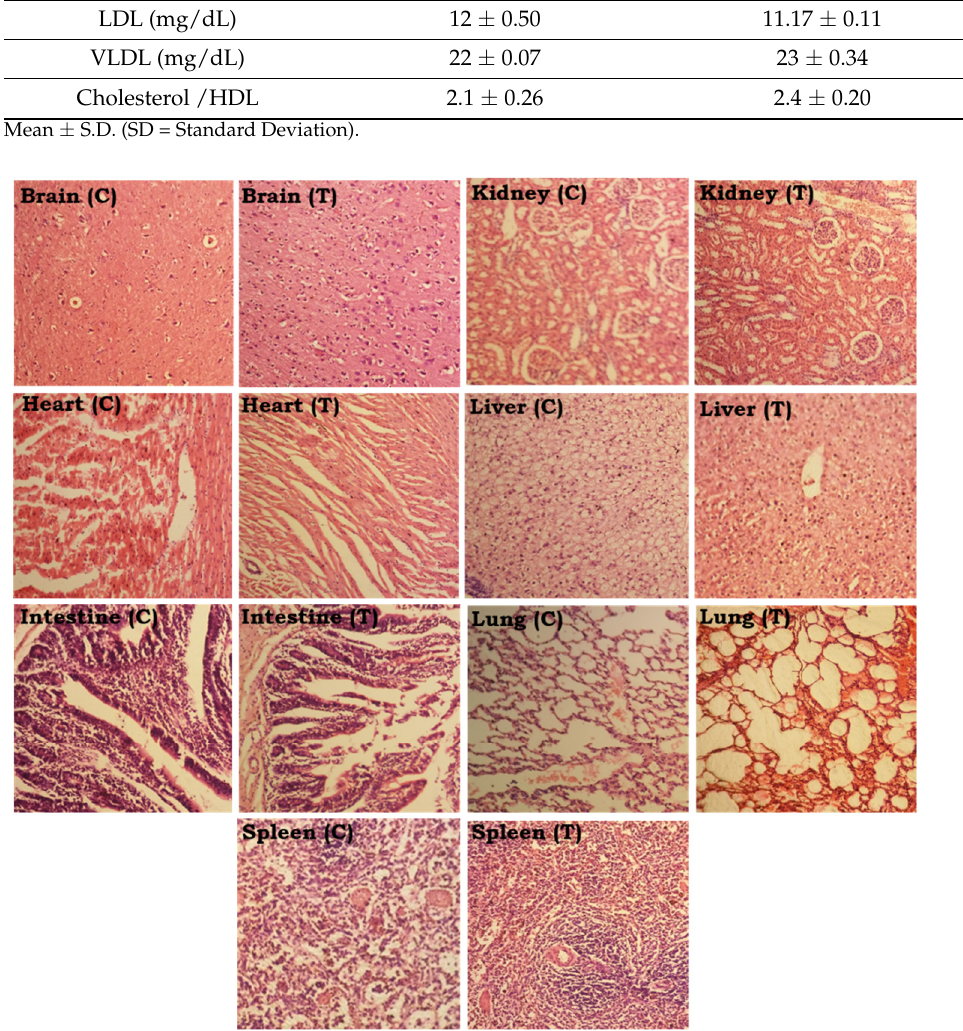
Figure 13. Images of the vital organs of the control group (C) and the Na-Alg/CP-poly(MAA) hydrogel-treated group (T) fourteen days after oral administration.